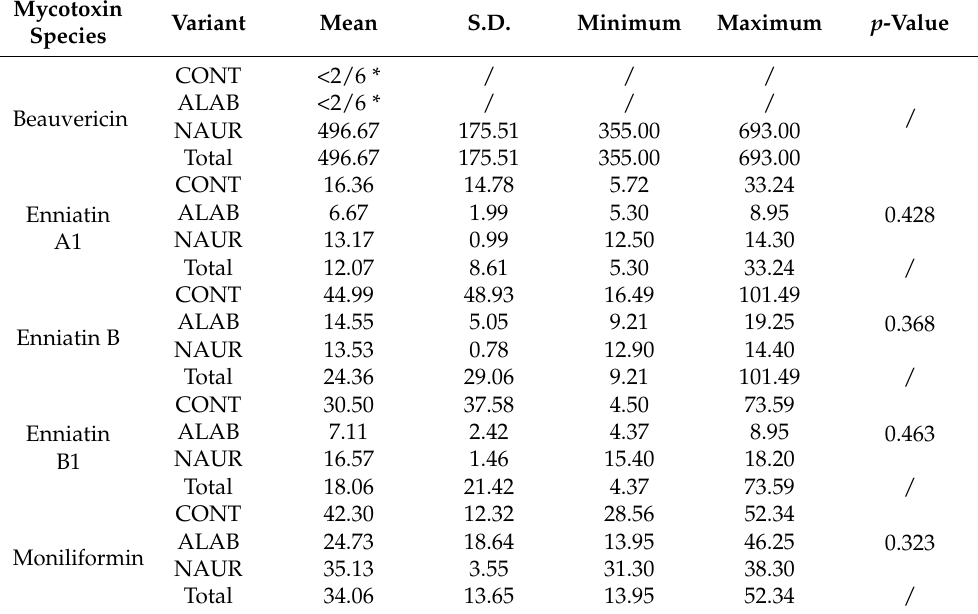
Table 6. The content of emerging mycotoxins in corn silage variants in µ